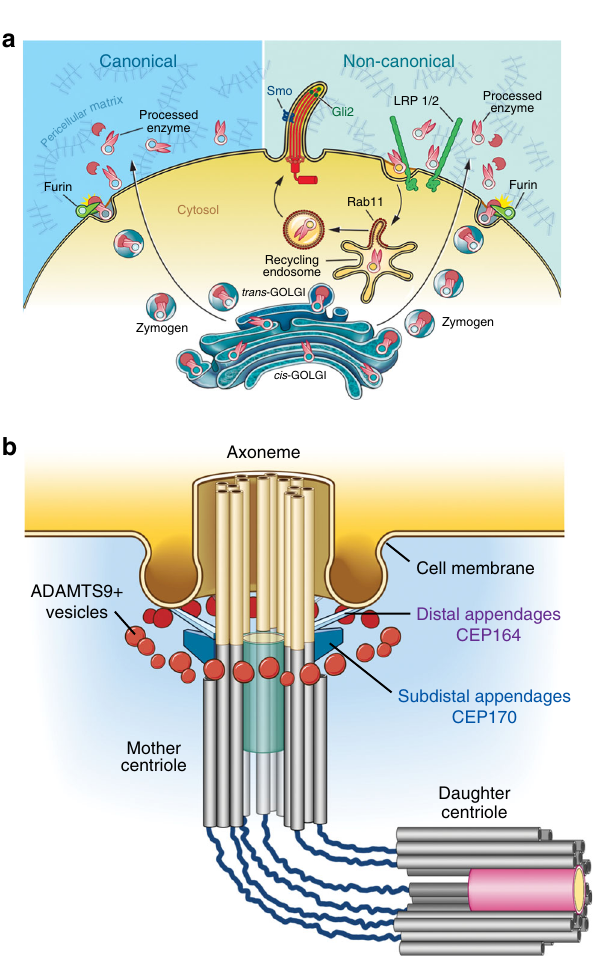
Fig. 10 The voyage of ADAMTS9 to the base of the primary cilium. a Schematic summarizing the life cycle and dual role of ADAMTS9 in ECM remodeling (left-hand side) and ciliogenesis (right-hand side). b Schematic illustrating the geographical distribution of ADAMTS9 vesicles at the ciliary Hybridization was done using a HybEZ oven and detected using the 2.5 HD Red detection kit. Hematoxylin was used as the counterstain. Sections were photo- graphed on an Olympus BX51 upright microscope (Olympus, Center Valley, PA) using a Leica DFC7000T camera and Leica Application Suite v4.6 imaging software (both from Leica, Wetzlar, Germany).